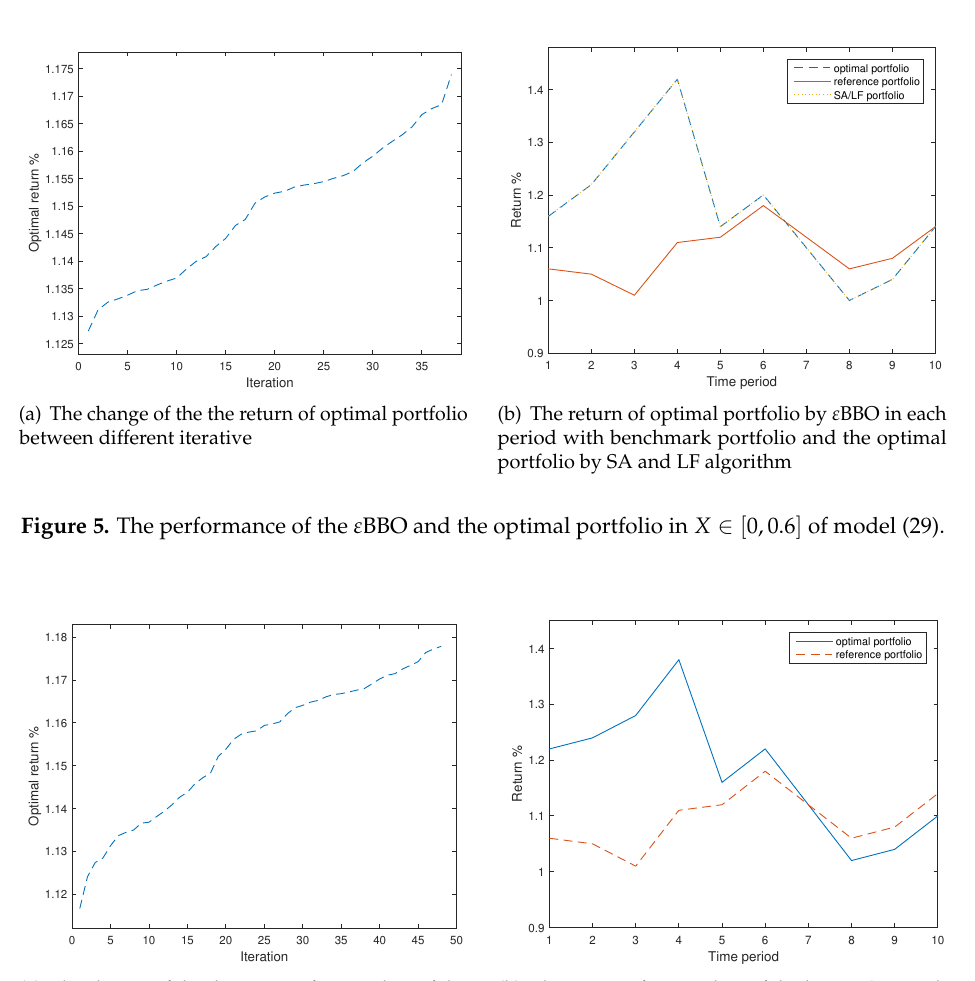
(b) The return of optimal portfolio by ε BBO in each period with benchmark portfolio Figure 6. The performance of the ε BBO and the optimal portfolio in X ∈ [ 0,1 ] of model